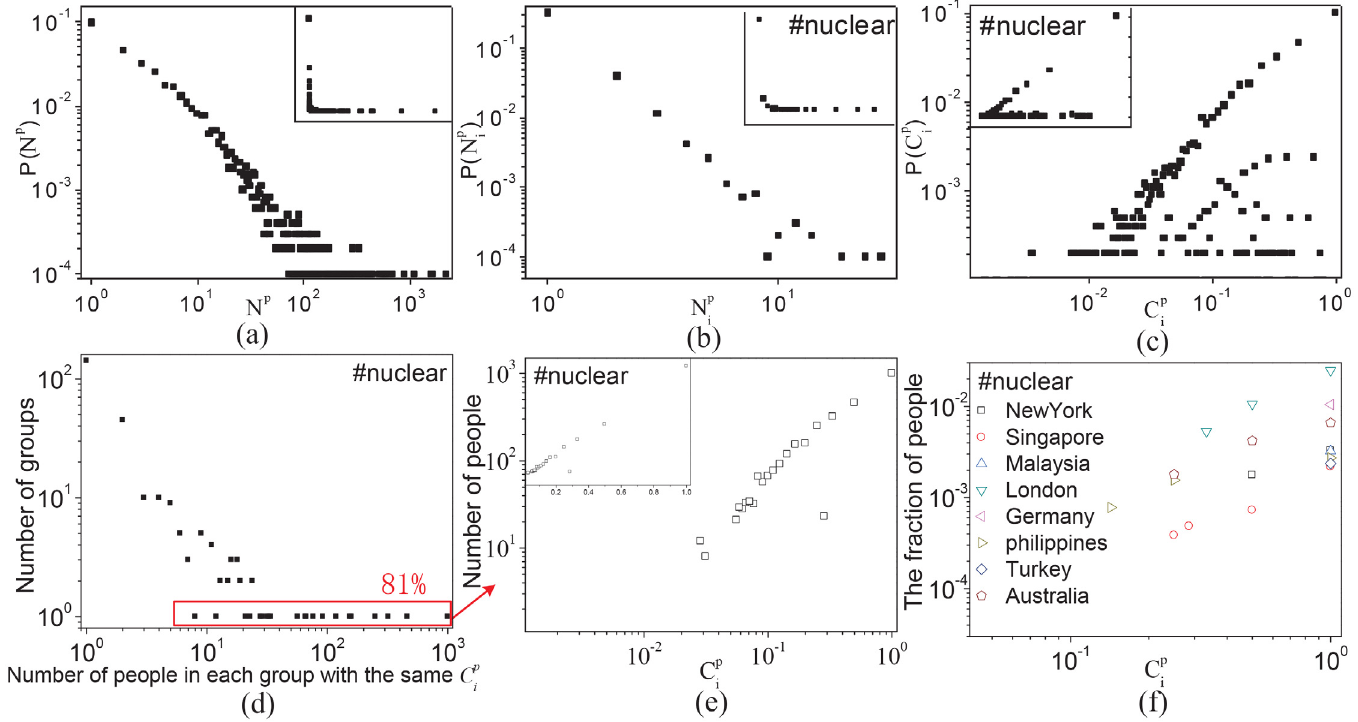
Fig 3. Statistical results of collective behaviors. (a) The regularity of active users and their tweets, i.e., the distribution of N p of people. (b)(c) The regularity of active users about ‘ #nuclear ’ , i.e., the distribution of N p #nuclear and C p #nuclear of people, respectively. (d) The distribution of heterogeneous groups and the number of people in each group based on the same concern about ‘ nuclear ’ . A point ( x , y ) in (d) indicates that there is y different groups and each group have x people with the same C p . (e) The distribution of C p where y = 1 in (d), which covers almost 81% of the total people in (c). More speci fi cally, each dot in (e) is aggregated over all people in different regions as shown in (f). (f) The self-similarity distribution of C p (where y = 1) on the nuclear crisis in different regions. There exist an internal consistency of the distribution of concerns about an event among different regions. Through extending hashtag ‘ #nuclear ’ to term ‘ nuclear ’ , such a nonlinear characteristic is becoming more evident as shown in Fig G in S1 Appendix.